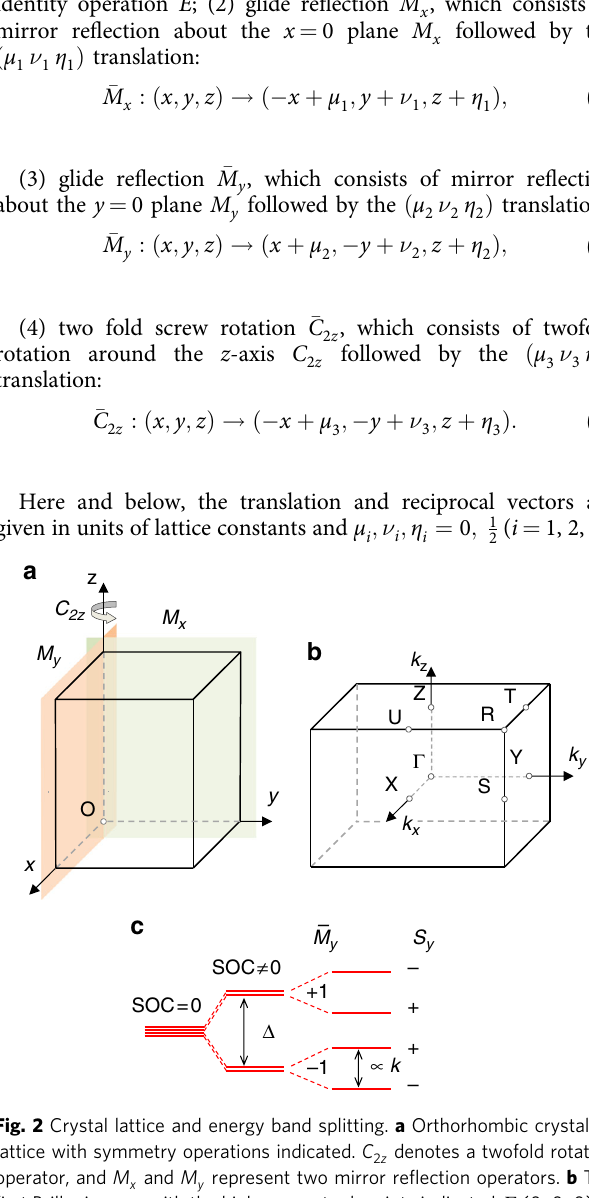
Fig. 2 Crystal lattice and energy band splitting. a Orthorhombic crystal lattice with symmetry operations indicated. C 2 z denotes a twofold rotation operator, and M x and M y represent two mirror re fl ection operators. b The fi rst Brillouin zone with the high symmetry k points indicated: Γ (0, 0, 0), X ( π , 0, 0), S ( π , π , 0), Y (0, π , 0), Z (0, 0, π ), U ( π , 0, π ), R ( π , π , π ), and T (0, π , π ), the k point coordinates are given in units of the reciprocal lattice constants. c Schematic splitting of the energy levels around the X point. SOC splits the state into two doublets with eigenvalues of (cid:1) M y ¼ ± 1, which are further split into singlets with sign-reversed expectation values of s y